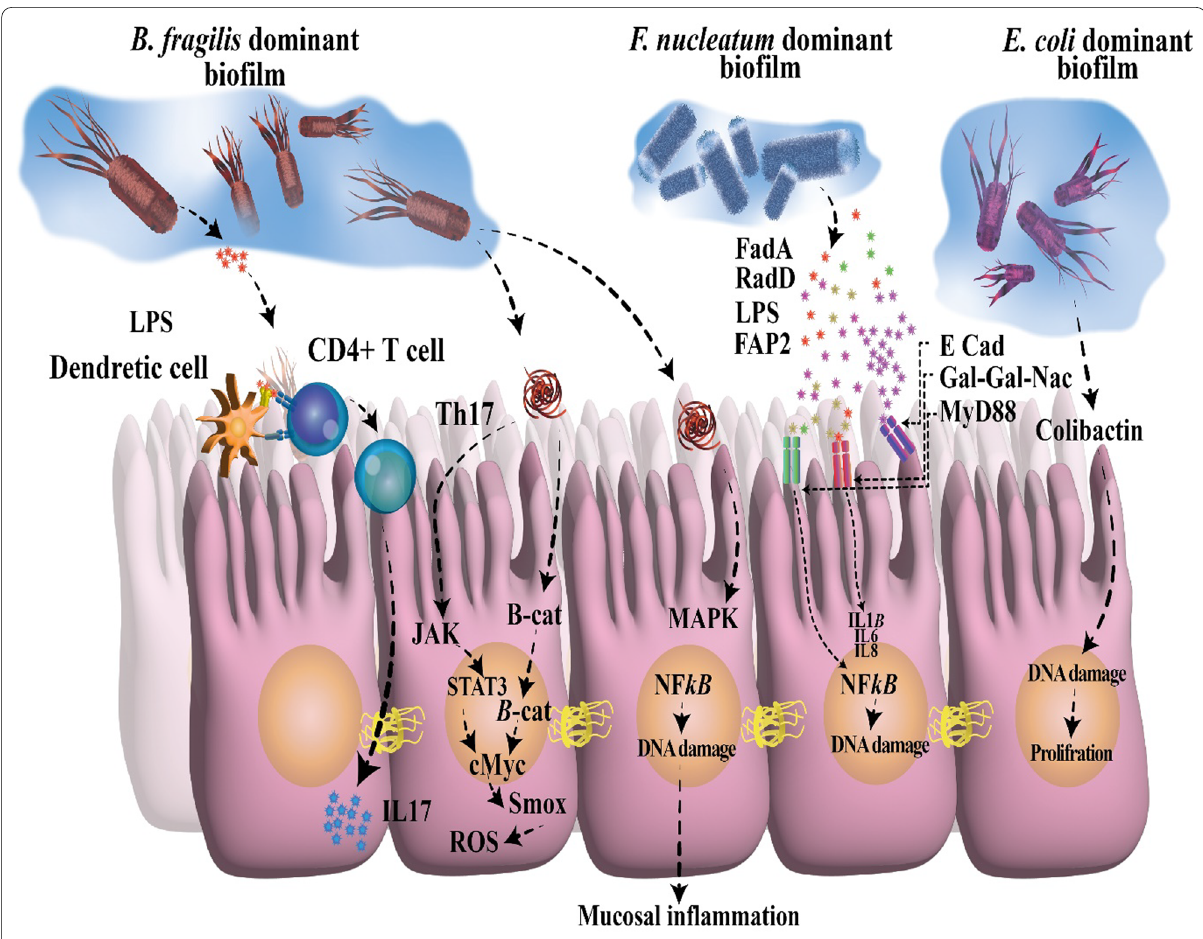
Fig. 1 The polybacterial biofilm in colonic mucus. Bacterial biofilm can cause enhance the gut permeability, change of E-cadherin in colonic cells. Besides, biofilm can cause the loss of intestinal barrier activity, resulting in dysbiosis that could favor the enhanced growth of opportunistic pathogens. Eventually, the pro-oncogenic role of the biofilm and changes of polyamine metabolic and inflammation-associated Th17 prompt the growth of host cells, resulting in CRC initiation. CRC, colorectal